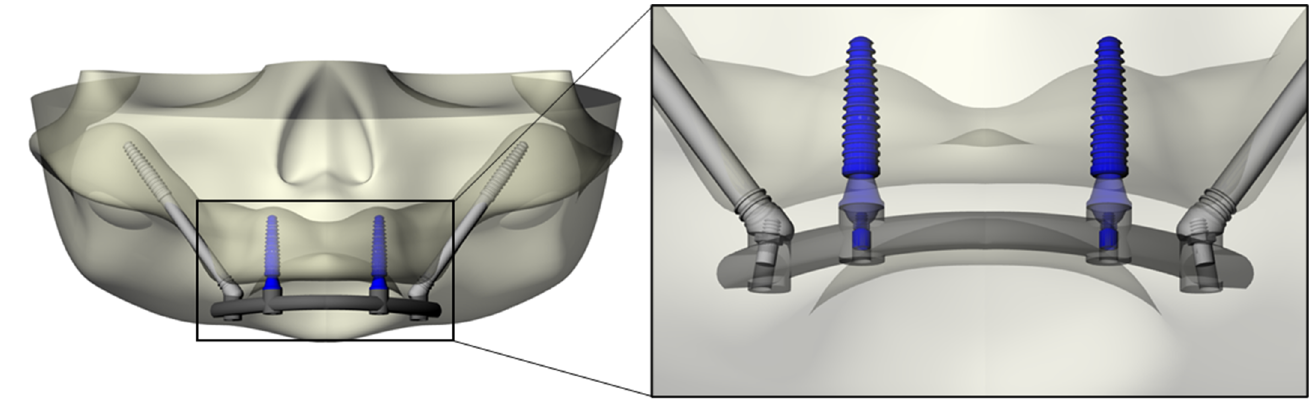
Figure 2. Three-dimensional simulated model developed for the present study. At higher magnification, it is possible to observe the implants, abutments, prosthetic screws and position of the superstructure.